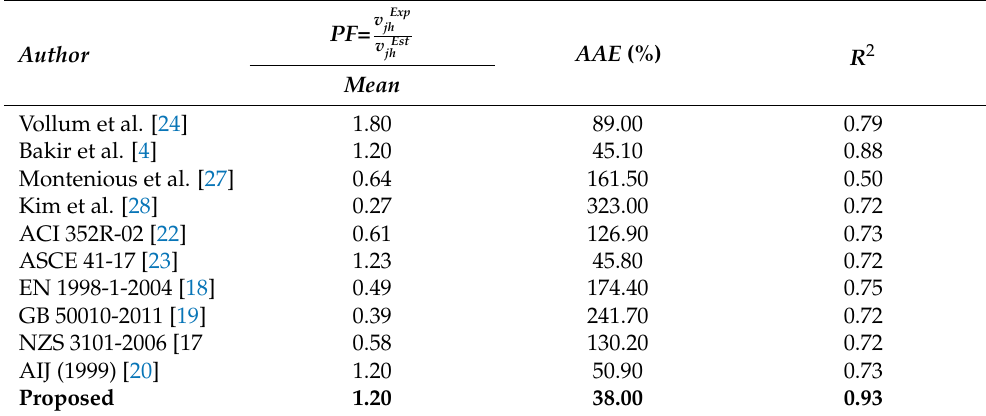
Table 3. Statistical calculations of the unreinforced RC exterior joint.